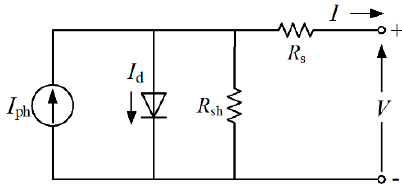
Figure 2. Equivalent circuit of a PV cell (one diode model).